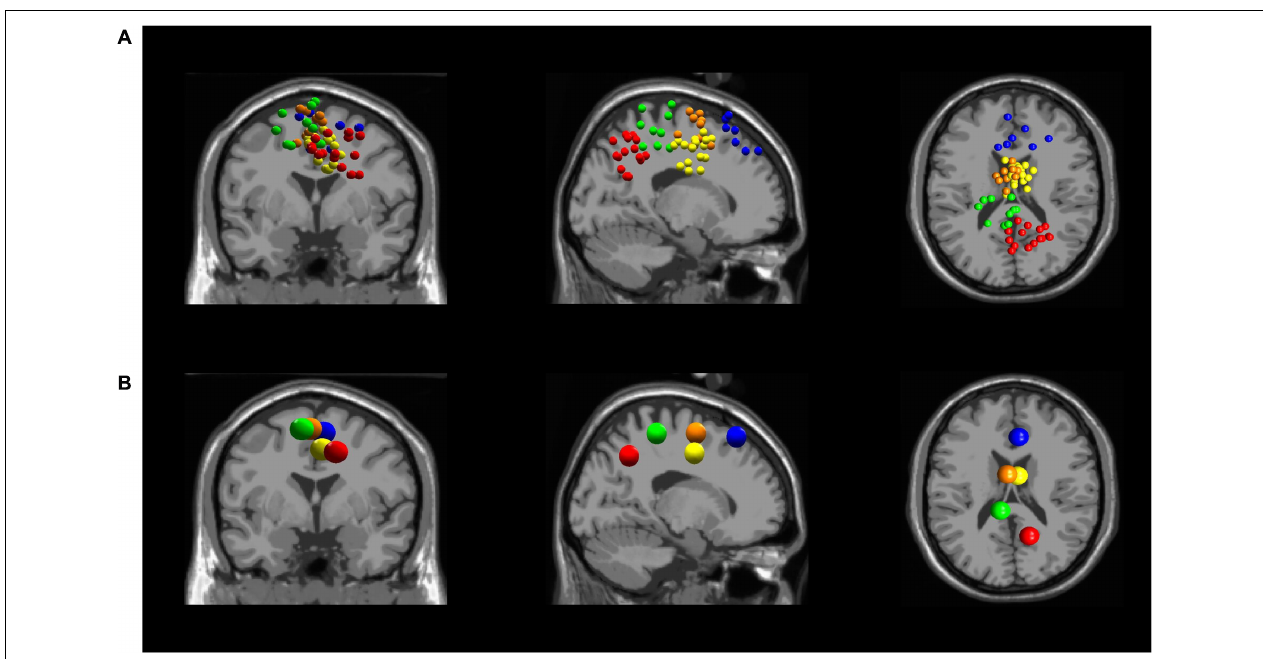
FIGURE 3 | (A) All independent component locations for each of the five averaged independent components in the (from left to right) coronal, sagittal, and transverse planes. Five clusters were found in different locations in the brain: Dorsolateral Prefrontal Cortex (blue), Somatosensory Association Complex (red), Left Sensorimotor Area (green), Pre-motor and Supplementary Motor Cortex (orange), and Midcingulate (yellow). (B) Independent cluster centroids plotted in the (from left to right) coronal, sagittal, and transverse